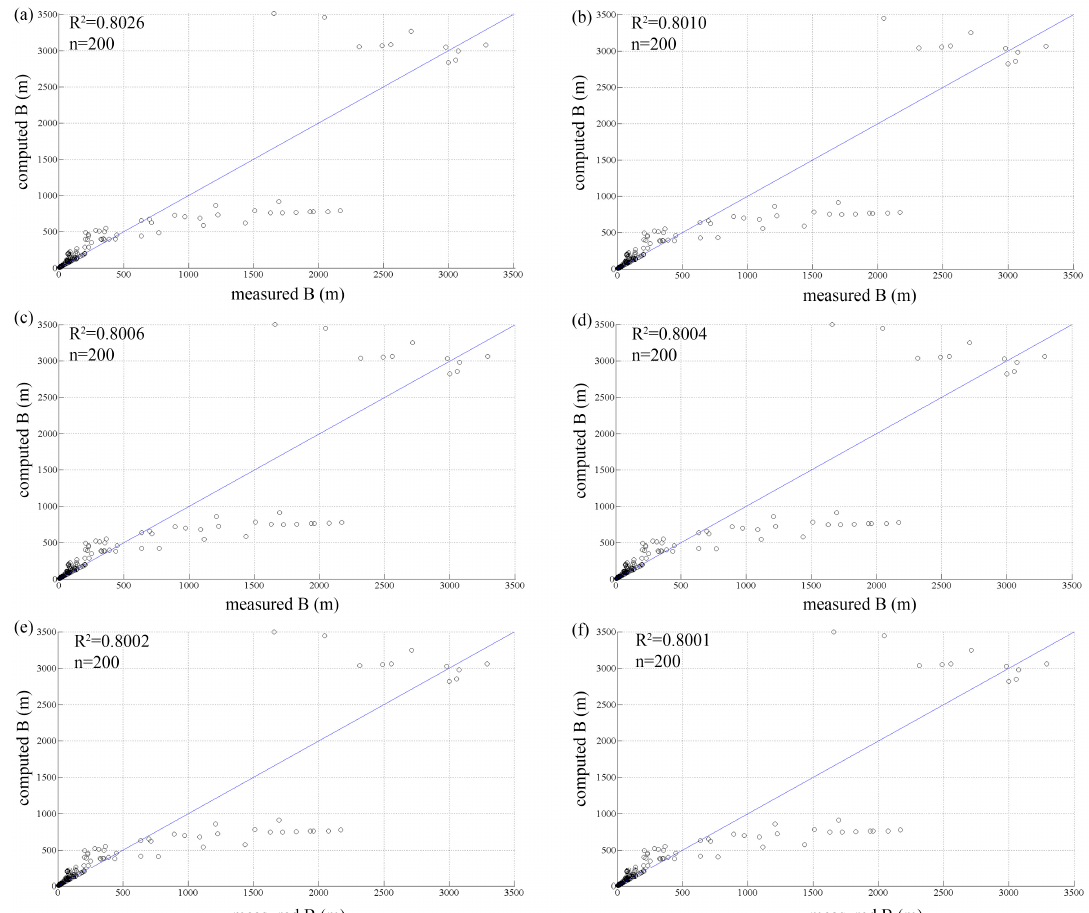
Figure 3. Comparison between computed and measured active river width B for different initial populations ( P 0 ): ( a ) P 0 = 10; ( b ) P 0 = 50; ( c ) P 0 = 100; ( d ) P 0 = 200; ( e ) P 0 = 500; ( f ) P 0 = 1000.